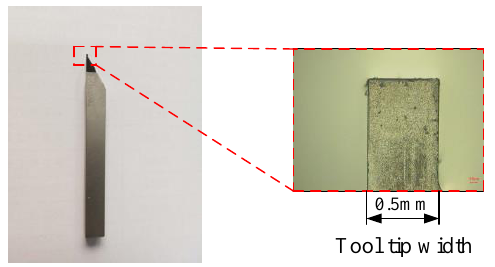
Figure 6. The cubic boron nitride (CBN) cutting tool. Table 4. Cutting tool parameters.